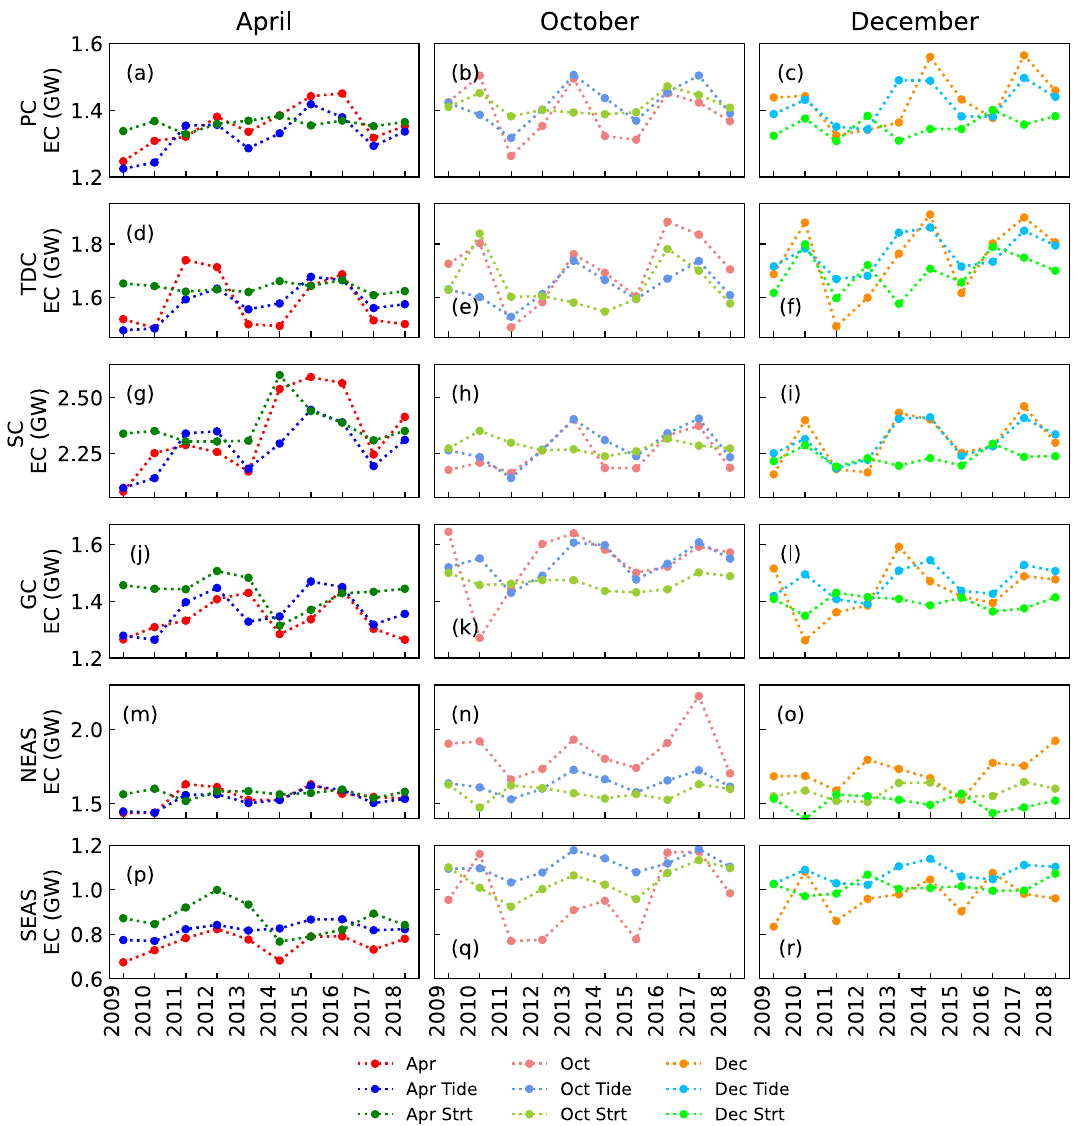
Figure 7. Interannual variability of semidiurnal IT energy conversion during April ( a , d , g , j , m , p ), October ( b , e , h , k , n , q ), and December ( c , f , i , l , o , r ) at PC ( a – c ), TDC ( d – f ), SC ( g – i ), GC ( j – l ), NEAS ( m – o ), and SEAS ( p – r ). ‘Apr’, ‘Oct’, and ‘Dec’ are set of realistic experiments. ‘Apr Tide’, ‘Oct Tide’, and ‘Dec Tide’ are set of experiments to quantify the effect of tidal forcing. ‘Apr Strt’, ‘Oct Strt’, and ‘Dec Strt’ are set of experiments to quantify the effect of stratification changes. EC on y-axis label means ‘energy decreased from 0.34 to 0.13 despite baroclinic conversion increasing by 10.5%. The decrease in baroclinic dis- sipation at TDC, SC, and GC resulted in more baroclinic flux entering the Andaman Sea and the Bay of Bengal, even more so into the former region. This can be seen along the western boundary of NEAS, where there is a sharp increase in the eastward propagating baroclinic flux from pIOD (0.15 GW) to nIOD (0.56 GW). Although there is a decrease in baroclinic conversion in NEAS, there is an increase in dissipation due to the dissipation of remotely generated IT. The maximum increase in the amount of IT generated (26.9%) and dissipated (27.1%) is seen in SEAS, where the westward propagation of baroclinic flux also increased from 0.08 GW to 0.2 GW. The mean vertical profiles of temperature, salinity, and buoyancy frequency for multiple pIOD and nIOD events during Autumn are shown in Supplementary Fig. S2 online. The maximum sub-surface stratification during different pIOD (nIOD) is near 50 m (100 m). Therefore, the semidiurnal IT energetics could be similar to that of 2006 for pIOD events and 2016 for nIOD events, respectively, albeit with some minor differences in magnitude owing to the differences in the strength of IOD events. During Winter (Fig. 8c,d), a similar trend of decreased local baroclinic dissipation at TDC, SC, and GC and increased propagation of IT into the Andaman Sea is observed from pIOD to nIOD even though its magnitude has differed. The local dissipation efficiency decreased from 0.52 to 0.37, 0.21 to 0, and 0.3 to 0.21, at TDC, SC, and GC, respectively. However, the IT generated at TDC remained constant during both the events, which was